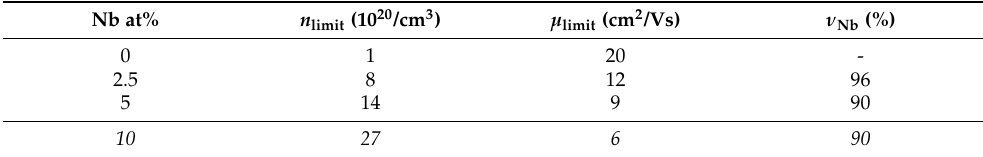
Table 2. List of the approximate limits of n and µ , which arose from Figure 3. The efficiency ν of the Nb doping was calculated, by subtracting 1 × 10 20 cm − 3 , assumed to be the maximum contribution of intrinsic oxygen vacancies. The resulting “excess” electron density was then divided by the Nb concentration. The 10 at% values are a prediction, assuming the blue line holds and ν = 90% persist. This would result in a resistivity of about 390 µ Ω cm. We omitted the efficiency of the 1 at% as for them the data-base is much smaller. Nb at% n limit (10 20 /cm 3 ) µ limit (cm 2 /Vs) ν Nb